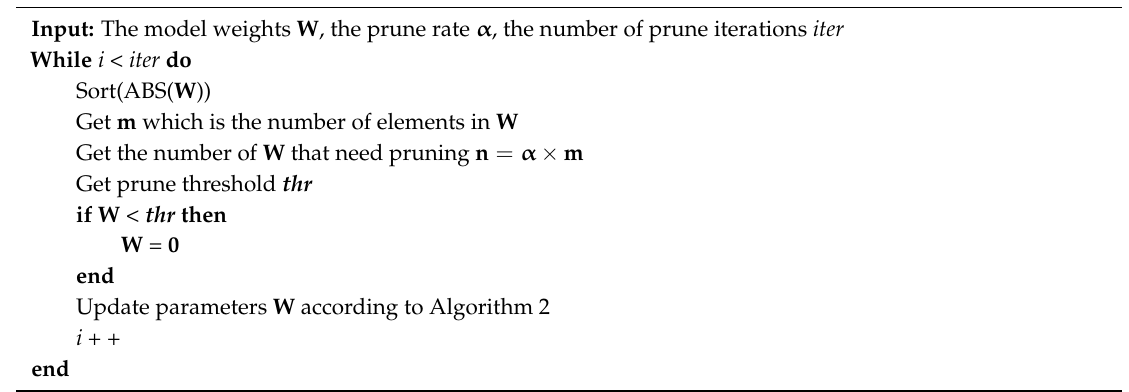
Algorithm 3: Pruning Parameters. ABS(x) indicate the absolute value for x. Sort(x) indicate sorting by the numerical value of x.